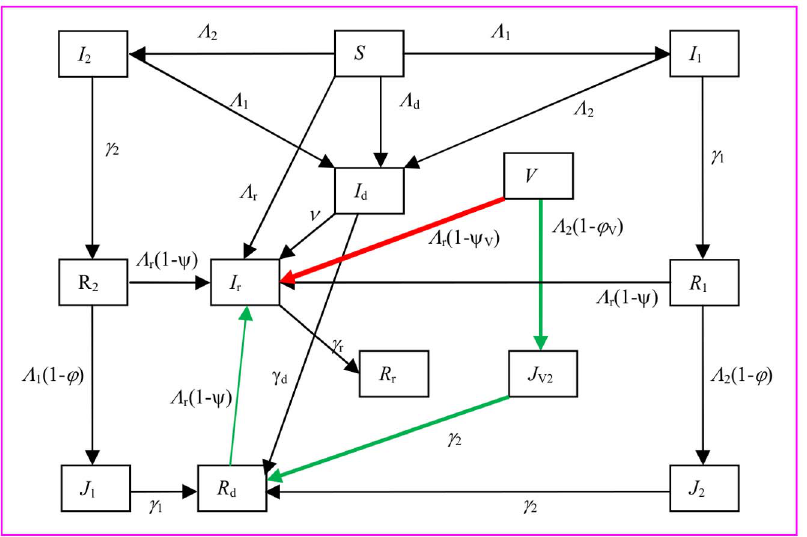
Fig. 1. Flow chart of the vaccination model. Arrows indicate transitions and expressions next to arrows show the per capita flow rate between compartments. Loss of immunity from recovered or vaccinated to susceptible, births and deaths are not shown. Variables and parameters are explained in Table 1, the force of infection L 1 , L 2 , L d, and L r are given in equations